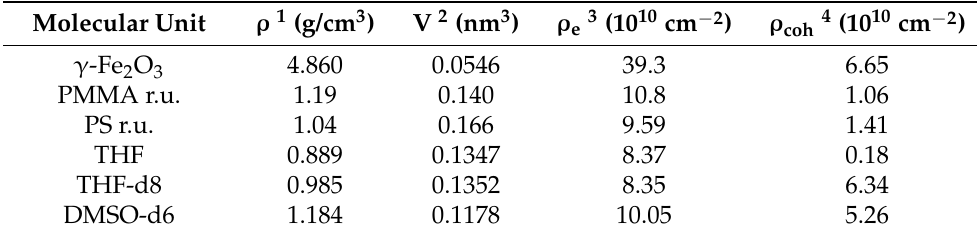
Table A1. Characteristics of the inorganic phases constituting the nanoparticles, the repeat units of polymer shells (r.u.), and the solvents of scattering experiments. Molecular